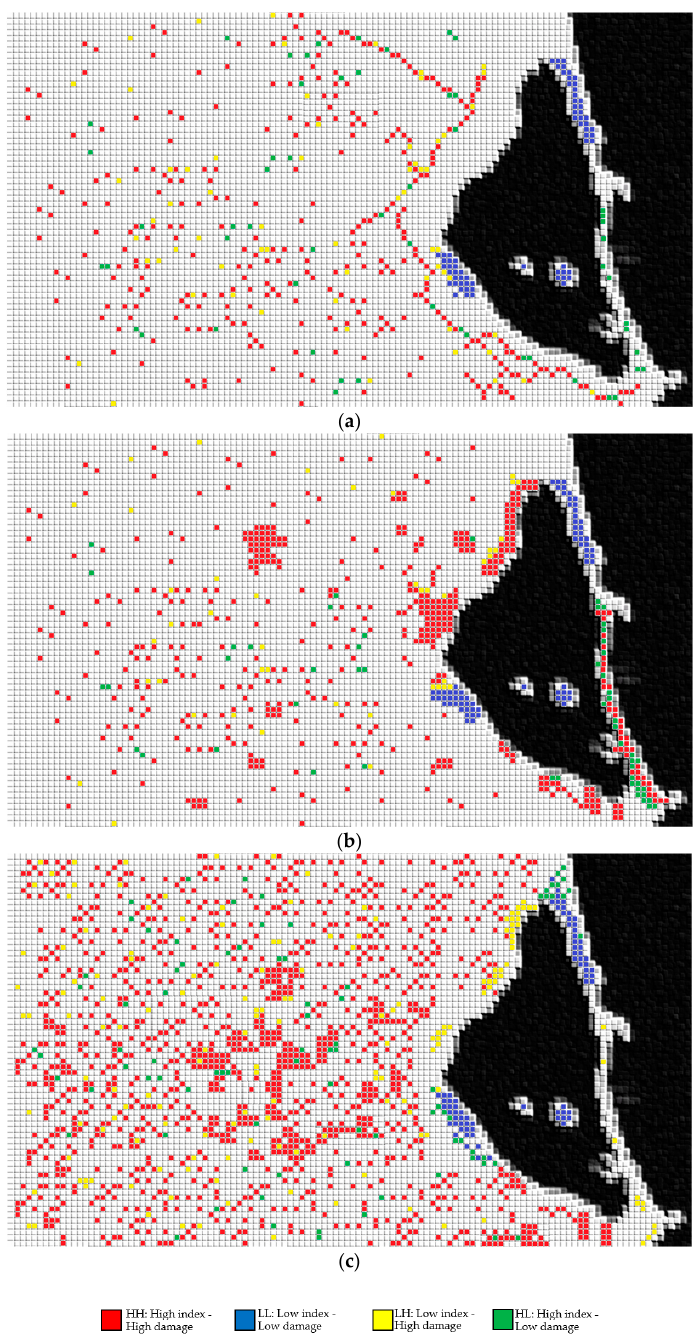
Figure 11. Hot- and cold-spot LISA analysis for spatial statistical correlation between damage and anthropization indices: ( a ) LID − I FDS ( b ) SA − I FDS and ( c ) ATO − I FDS . If the density of points is observed, it can be verified that the phenomenon of territorial anthropization that generates a greater link with the damages of the DANA is the territorial transformation associated with the alteration of the orography or land use. The one that generates the least association of damages from floods is the transformation derived